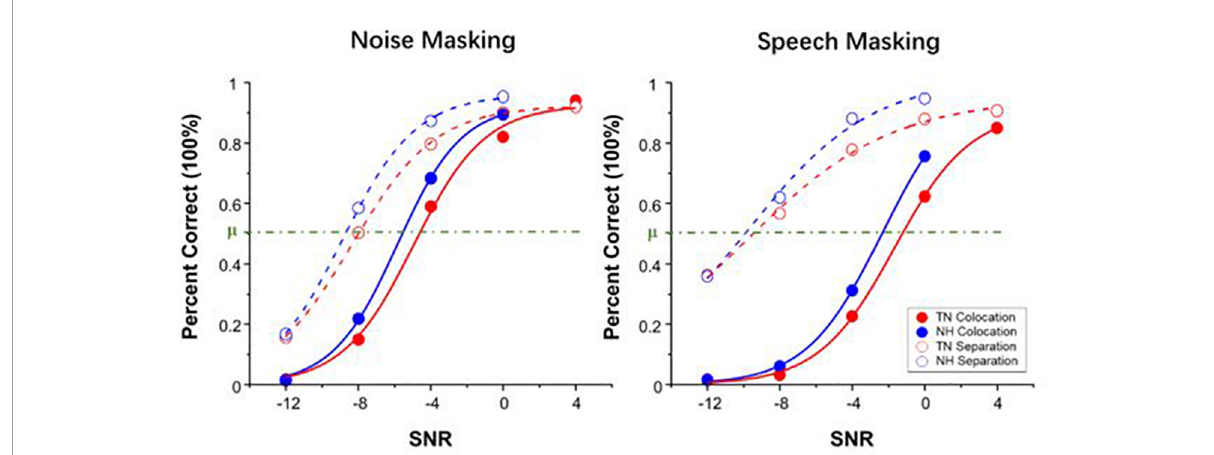
FIGURE2 Group mean percent of correct as a function of signal-to-noise ratio (SNR) in noise masking condition (left panel) and speech masking condition (right panel) . Red and blue represent the data of the TN group and NH group, respectively.